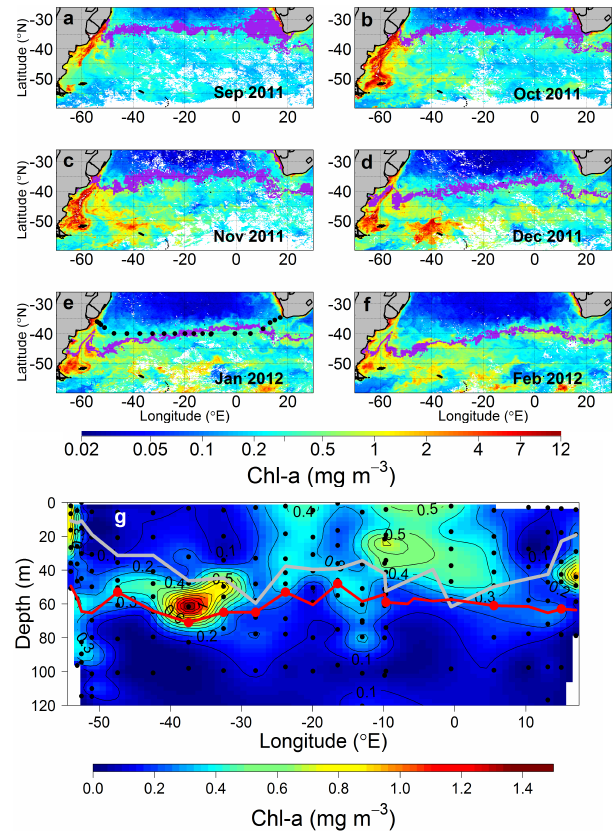
Fig. 3. MODIS monthly composite images (a–f) of chlorophyll a concentrations for September 2011–February 2012 around the At- lantic SSTC. Sampling locations are labelled for the January 2012 image which was the month of in situ sampling. Purple colour- ing represents SST = 16 ◦ C ( ± 0.5 ◦ C) and is shown as a practical definition of the SSTC location. (g) Cross-basin section of HPLC- derived chlorophyll a concentrations. Note the different scales for (a–f) and (g) . Grey line is the MLD. The red line is the euphotic depth ( z eu ) here defined as the 1% light depth, with red dots indi- cating where direct PAR measurements were used to calculate the depth and remaining variability reflecting z eu estimated using a de- rived chlorophyll a K d relationship ( K d = 0.016 Chlorophyll a +